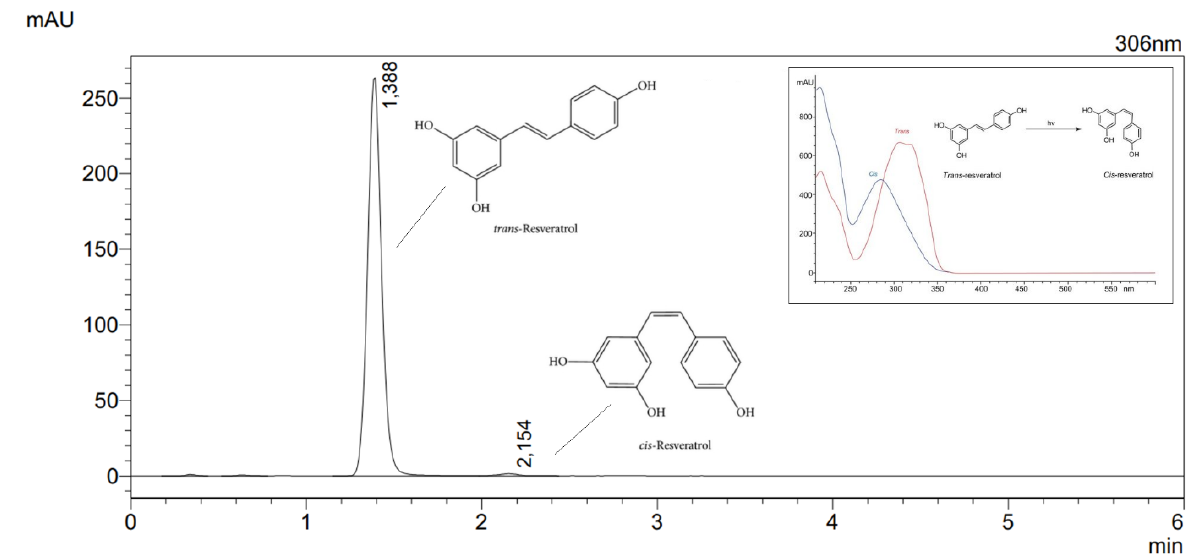
Figure 3. Chromatogram of RSV (c = 40 μ g mL − 1 ). 405